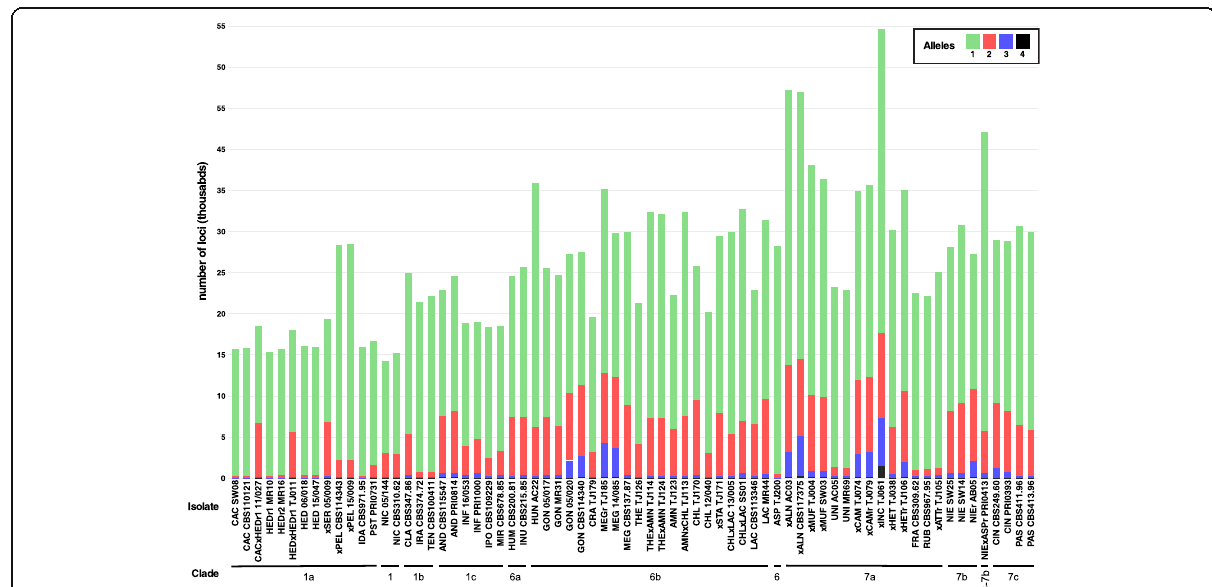
Fig. 4 Number of GBS loci with one to four alleles in representative Phytophthora isolates of clades 1, 6 and 7. The data for isolates of all clades are presented in Figure